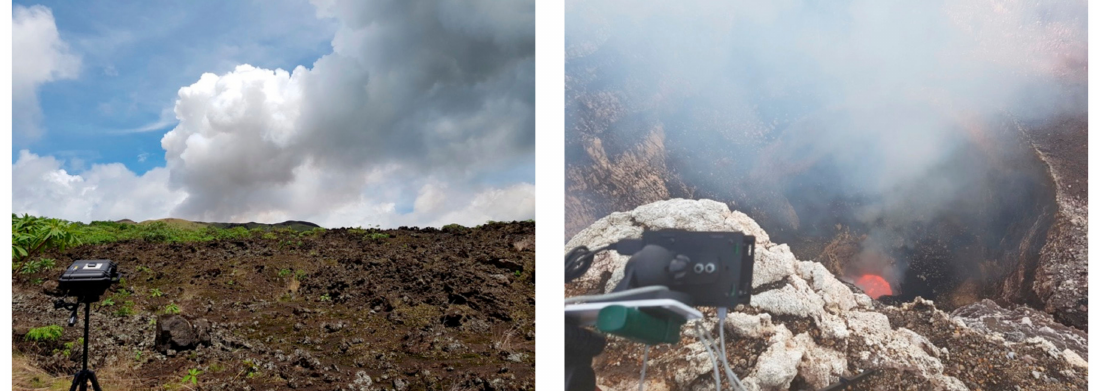
Figure 3. Smartphone sensor (e.g., Rasperry Pi camera)-based UV imaging deployments on the Masaya volcano, Nicaragua, during June 2017. Measurement of the plume taken from outside the crater ( left ); measurements looking down at the lava lake surface ( right